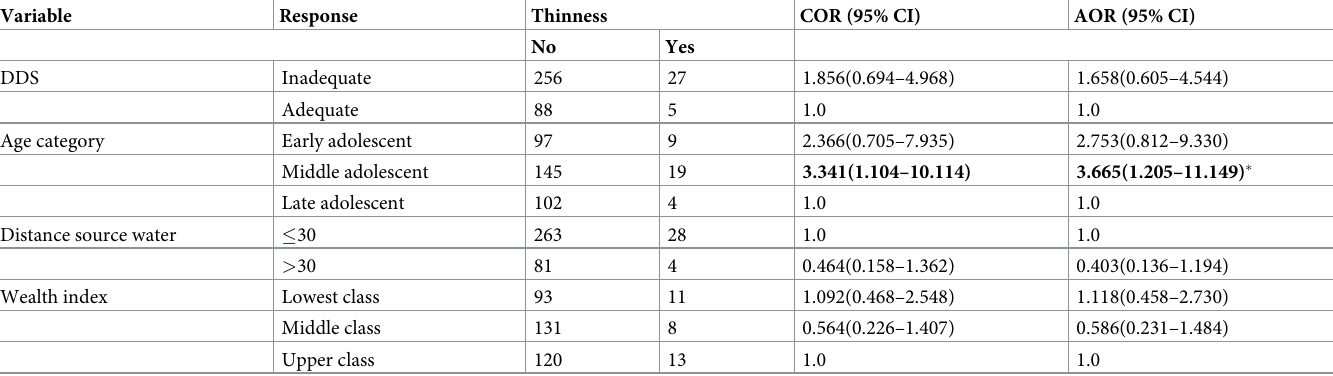
Table 6. Bivariable and multivariable logistic regression of factors associated with thinness among rural school adolescent girls, 2020 (n = 376). Variable